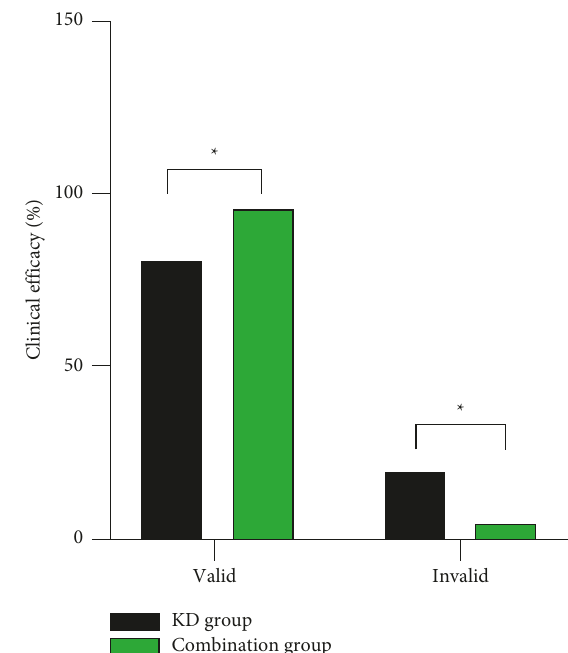
Figure 1: Clinical efficacy between the two groups of children. ∗ Difference between group comparisons, P < 0 .